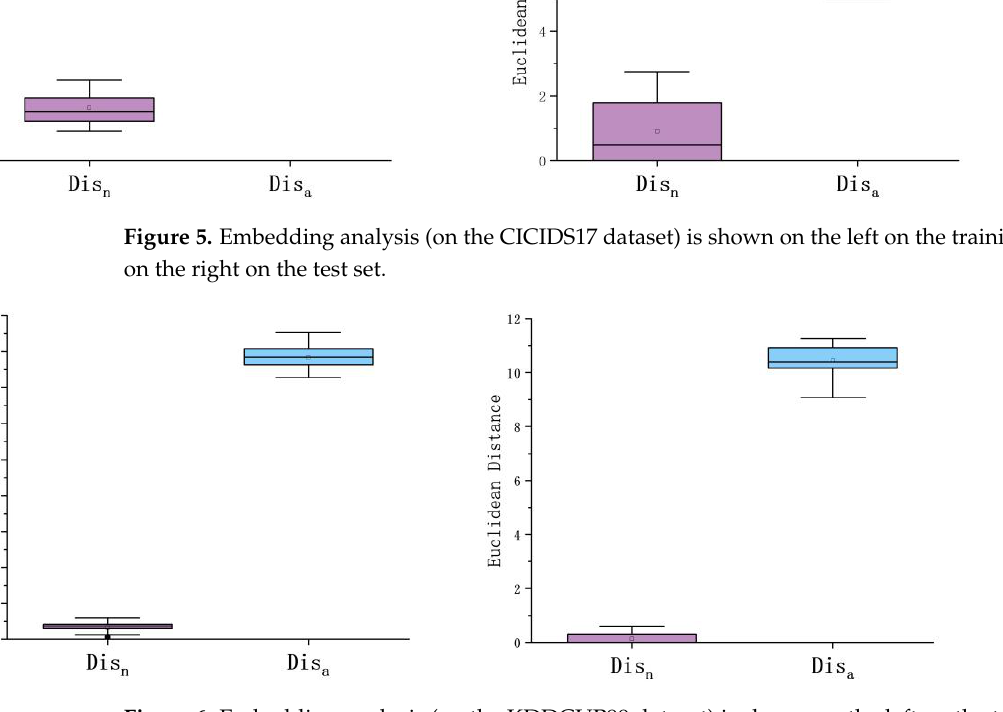
Figure 6. Embedding analysis (on the KDDCUP99 dataset) is shown on the left on the training set and on the right on the test set.